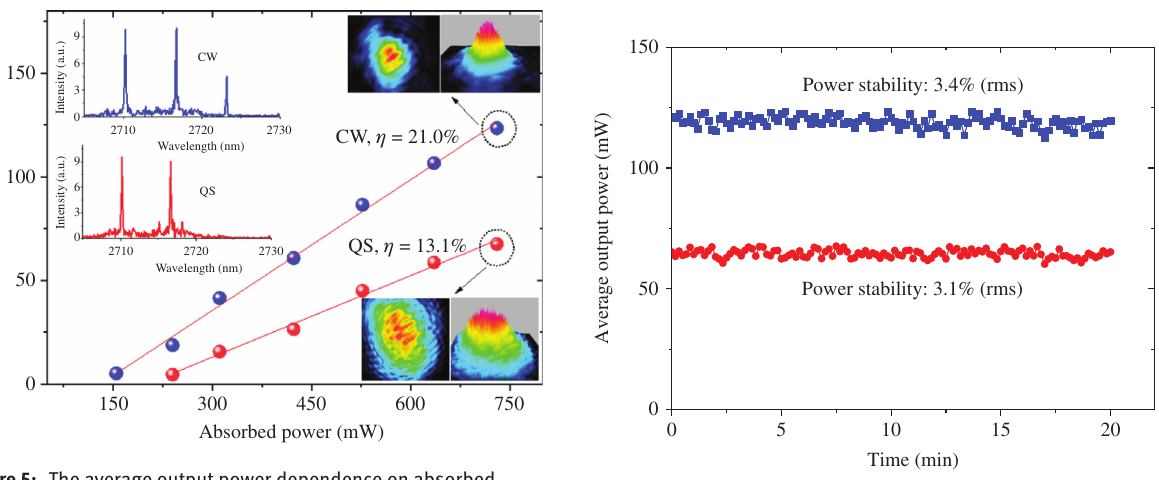
Figure 6: The laser output power stabilities under CW and passively Q-switched